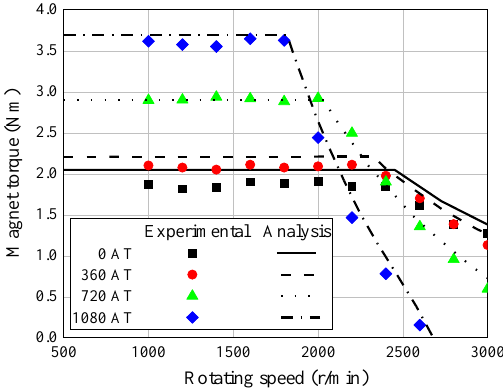
Figure 28. Experimental results of N–T characteristic.